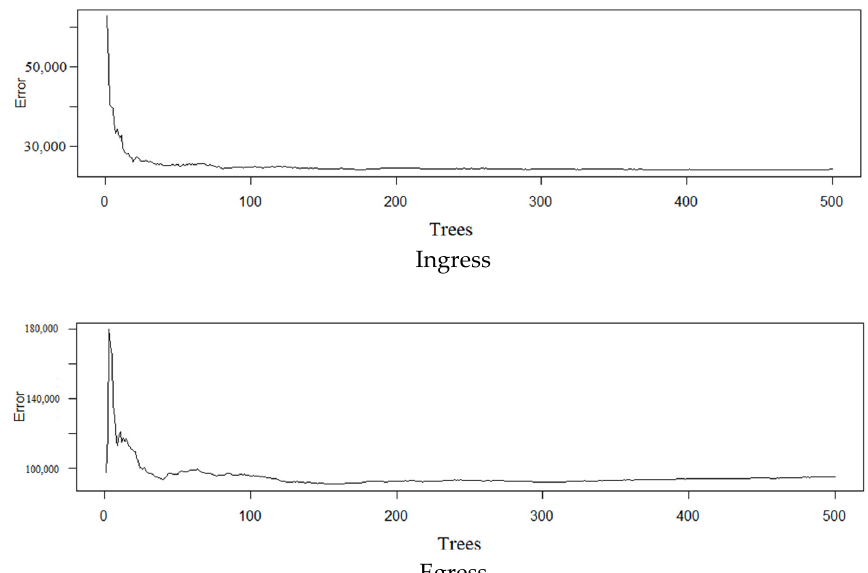
Figure 14. Ingress and egress OOB errors.